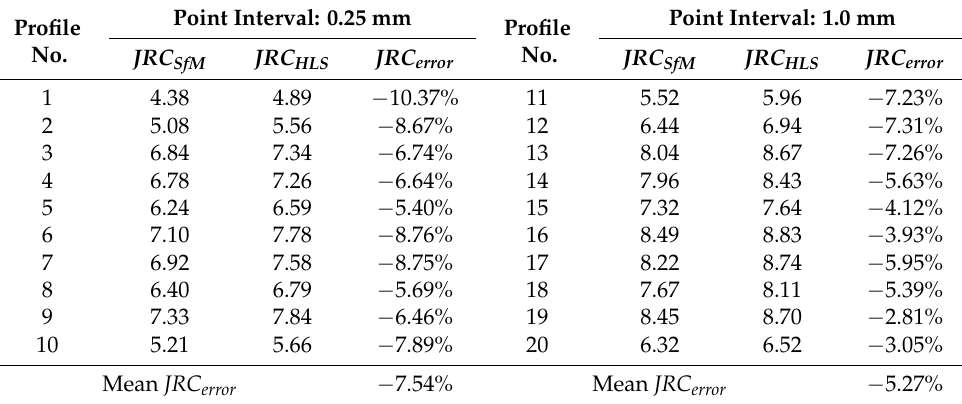
Table 8. JRC error of the 2D